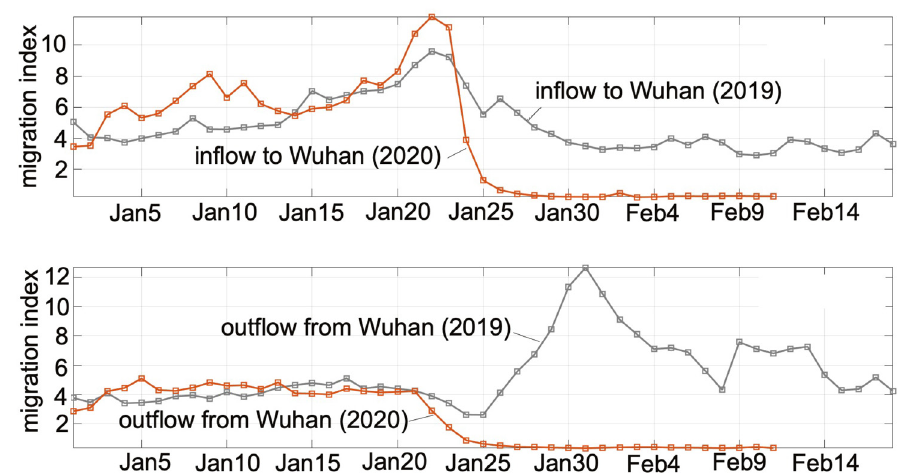
Fig 3. Inflow and outflow data of each city with individual cities collected using Baidu Migration data. Intercity migration strengths are used to form m ij .